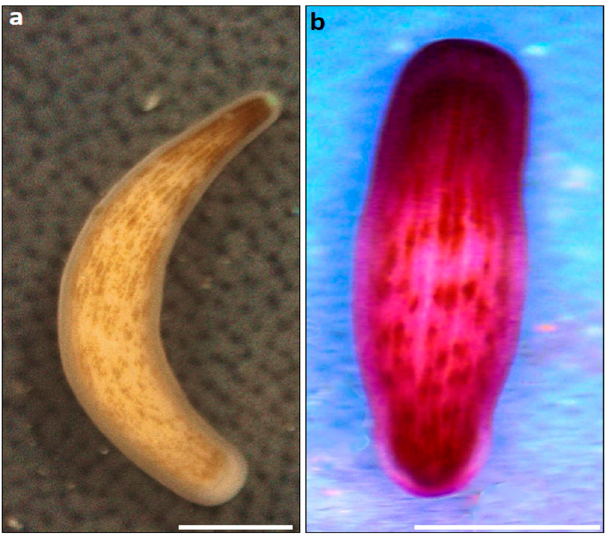
Figure 2. ( a ) An unstained planula. ( b ) A stained planula. Both photos were photographed using a 3.5×–90× trinocular stereo microscope (AmScope) equipped with a 10 MP USB microscope